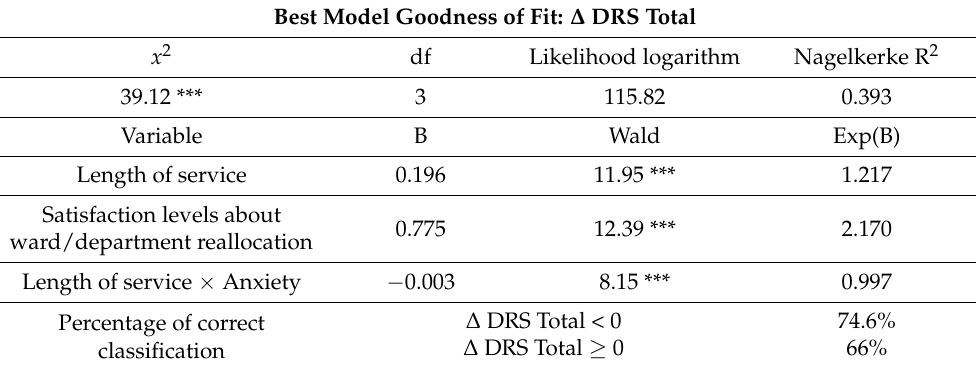
Table 20. Commitment predictors according to multivariate analysis (length of service, transfer evaluation, length of service × anxiety, and insufficient PPE (no) × transfer evaluation) and correct/incorrect classification of the model.